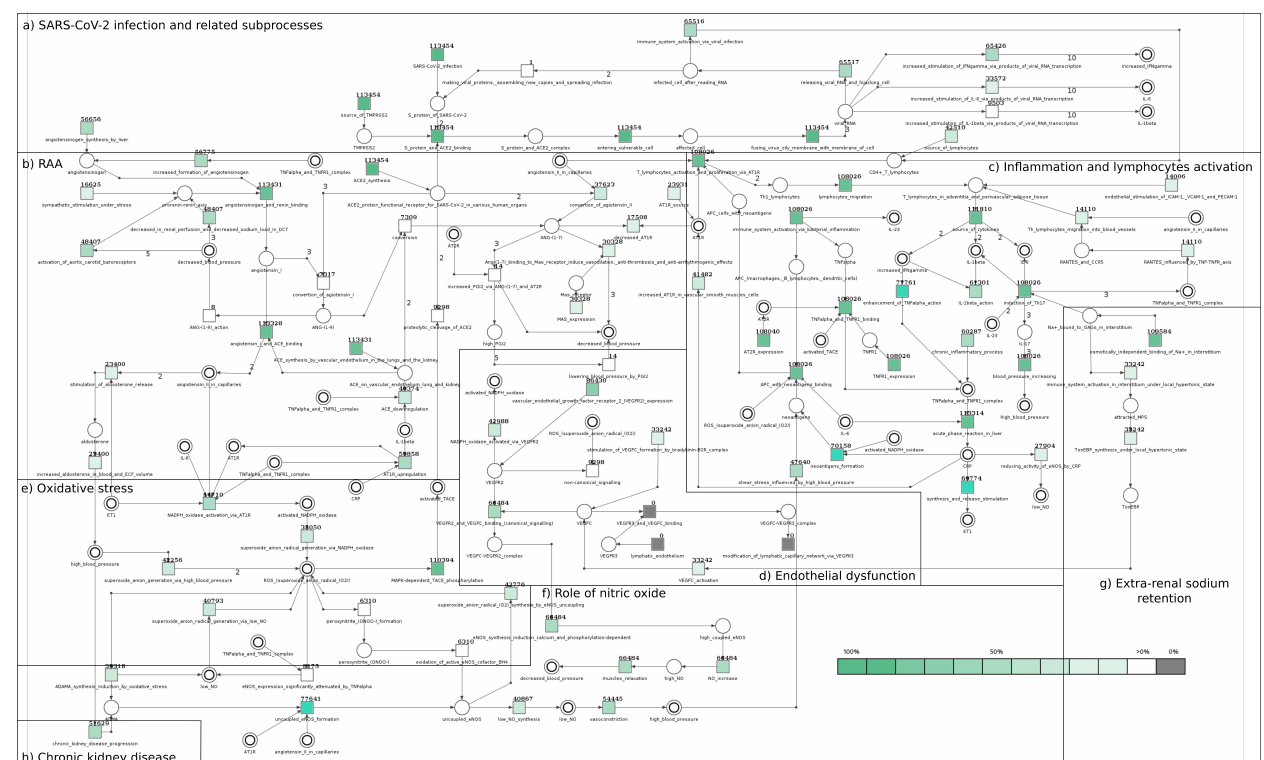
Figure 2. Significance analysis for each transition performed only for SARS-CoV-2 related t-invariants. Transitions are marked in a color gradient from white to different green saturations (if the color has a higher intensity, the given elementary process has greater significance) or they can be marked with a grey color (if transitions are not related to the t-invariants associated with the viral